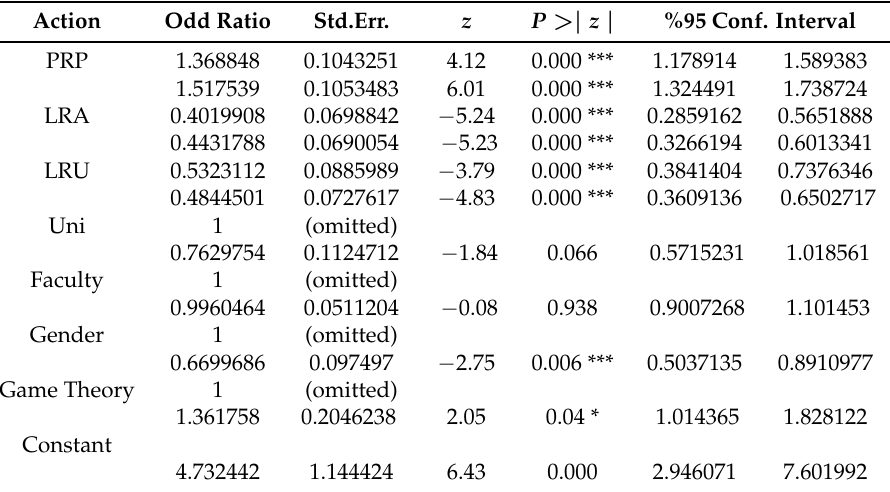
Table 5. Entrants-Panel Logistic Regression